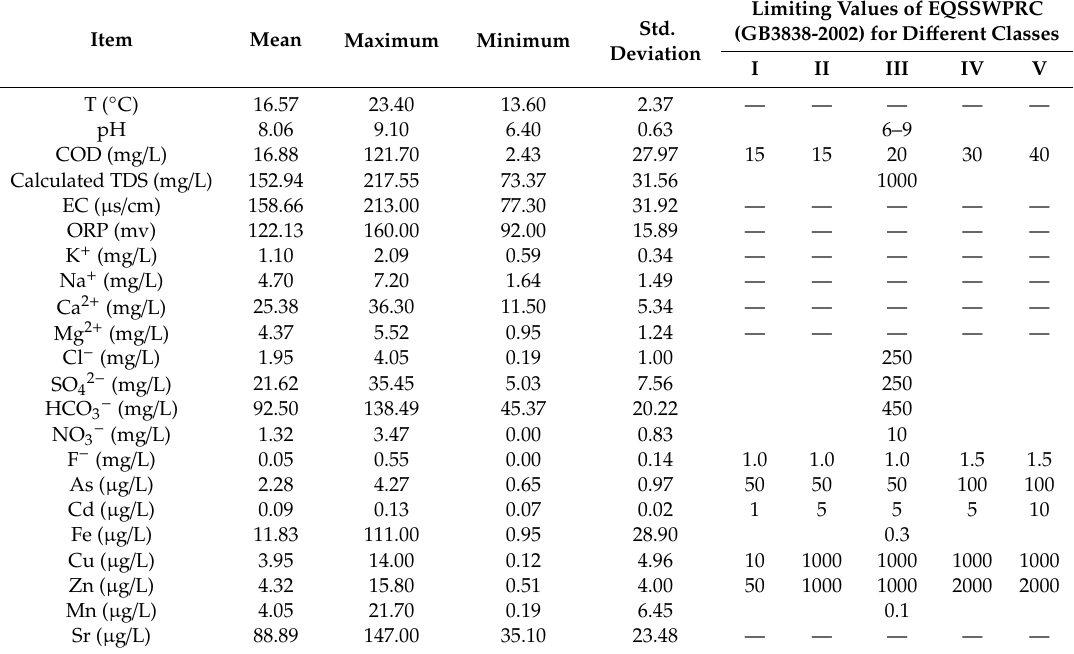
Table 2. Physicochemical data statistics: T, pH, EC, ORP, TDS, and ion compositions, where the classification standards of water quality are: (1) Class I, source water and state reserve; (2) class II, first-level protection zone of centralized domestic drinking surface water source, habitat of rare aquatic life, spawning grounds of fish and shrimp, feeding ground for young fish; (3) class III, second-level protection zone of centralized domestic drinking surface water source, fishery waters (fish and shrimp wintering grounds, migratory channels, aquaculture areas, and others), swimming area; (4) class IV, general industrial water areas and non-direct human contact recreational water areas; (5) class V, agricultural water areas and general landscape